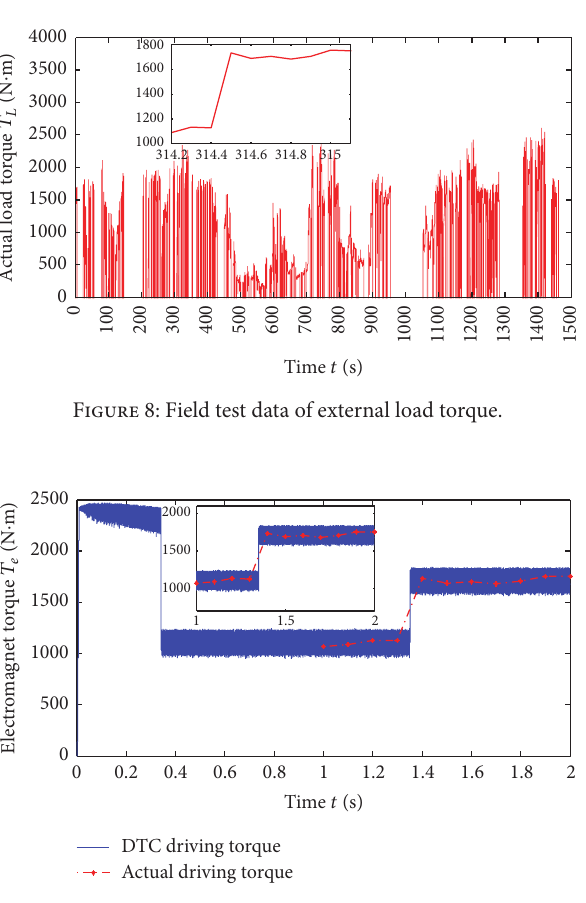
Figure 9: Actual driving torque of DTC